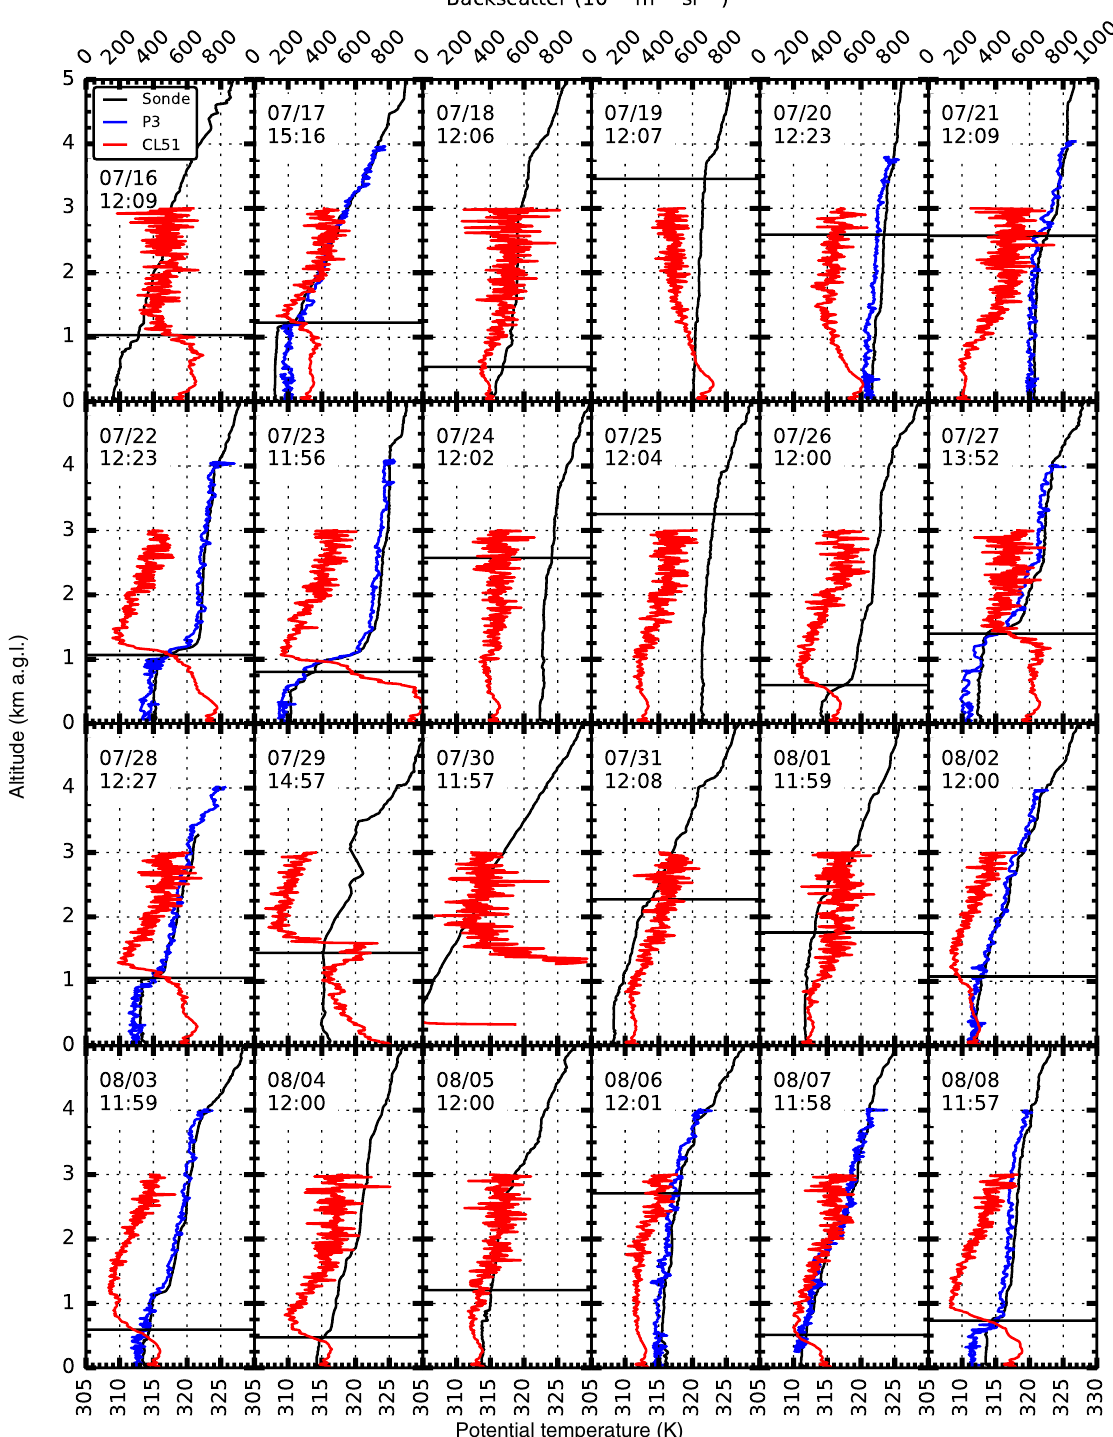
Figure 12. Potential temperature and Cl51 backscatter profiles collected at the BAO Tower site. Horizontal lines indicate MLH as determined by